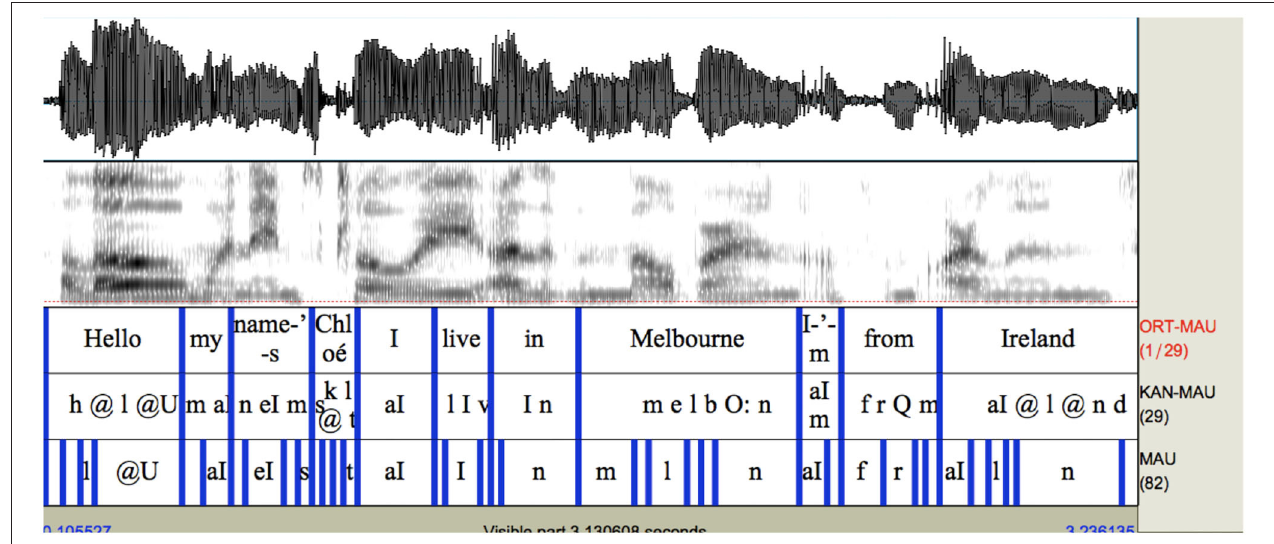
FIGURE 5 | Example of system output with the good quality recording using WEBMINNI, forced-alignment.